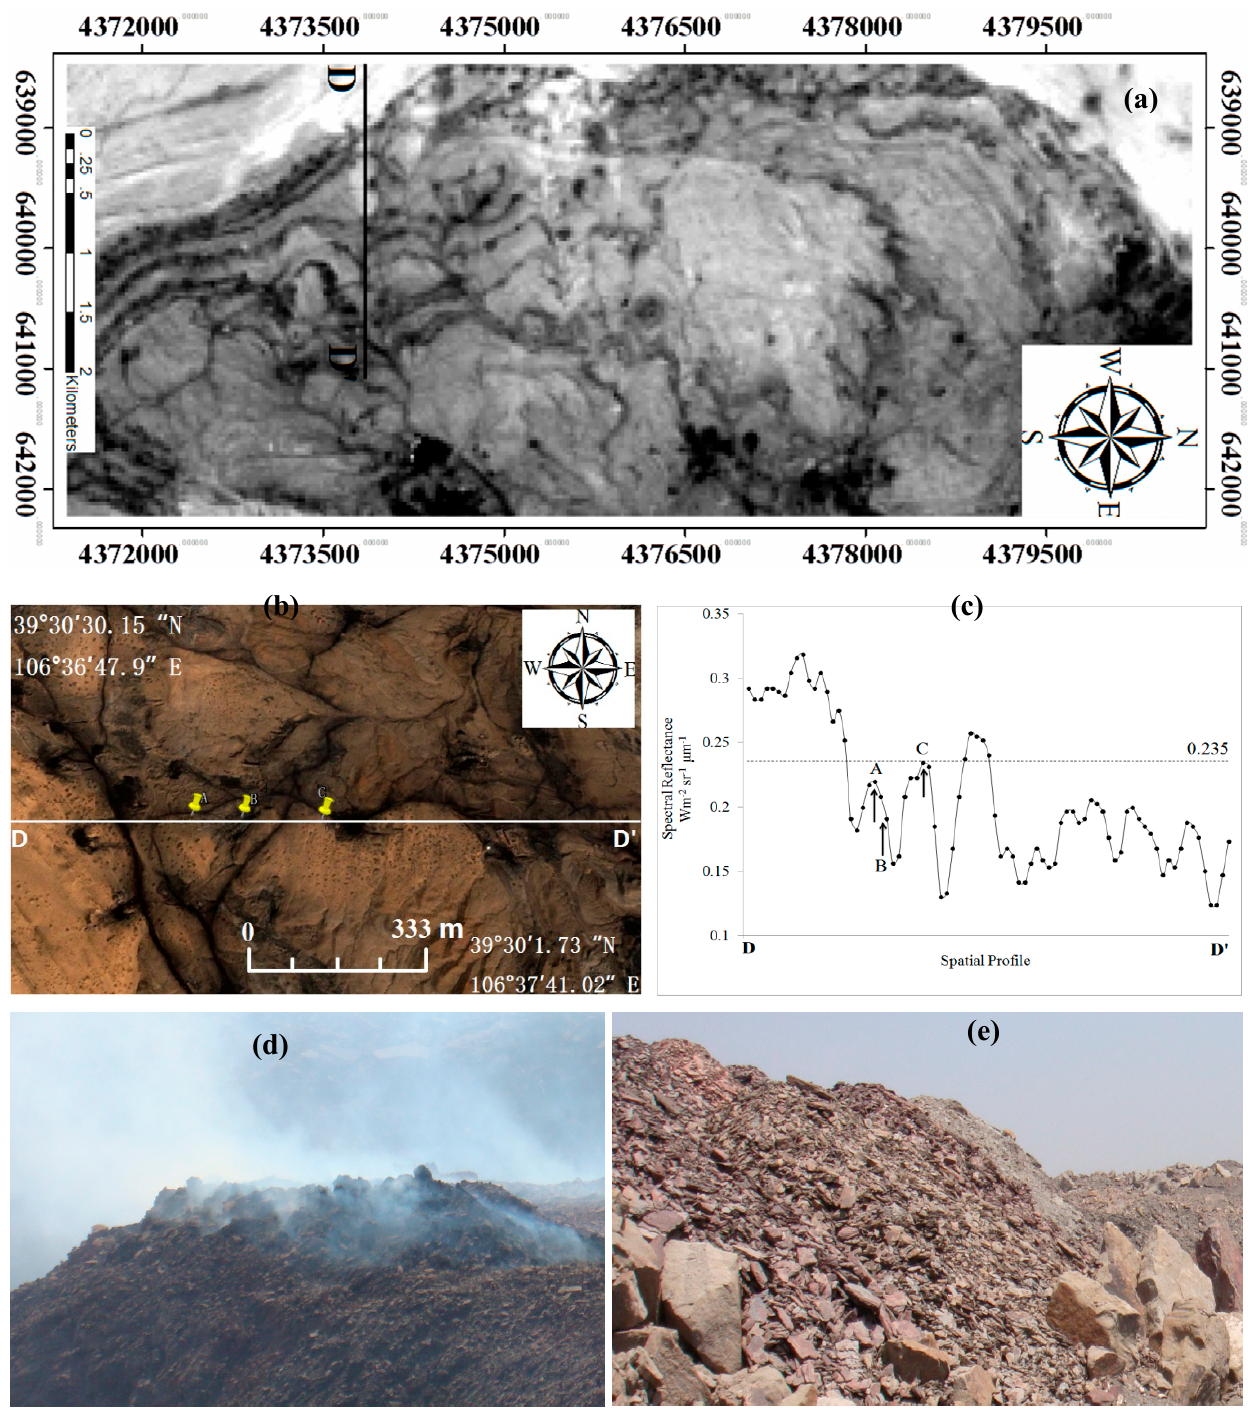
Figure 7. The methodology that was followed in the study to remove coal overburden wastes is presented here with a thresholding method using the WCF as an example. ( a ) The location of the selected profile line DD’ on Landsat TM band-7 image of 3 May 2003; ( b ) Underground coal fire location A and B and coal overburden dump location C along the selected spatial profile DD’ are shown as a reference on a very high resolution Google Earth TM back ground image of 5 October 2003; ( c ) Maximum reflectance along the spatial profile line DD’; ( d ) Field photograph of a coal fire location B; ( e ) Field photograph of a coal overburden dump at location